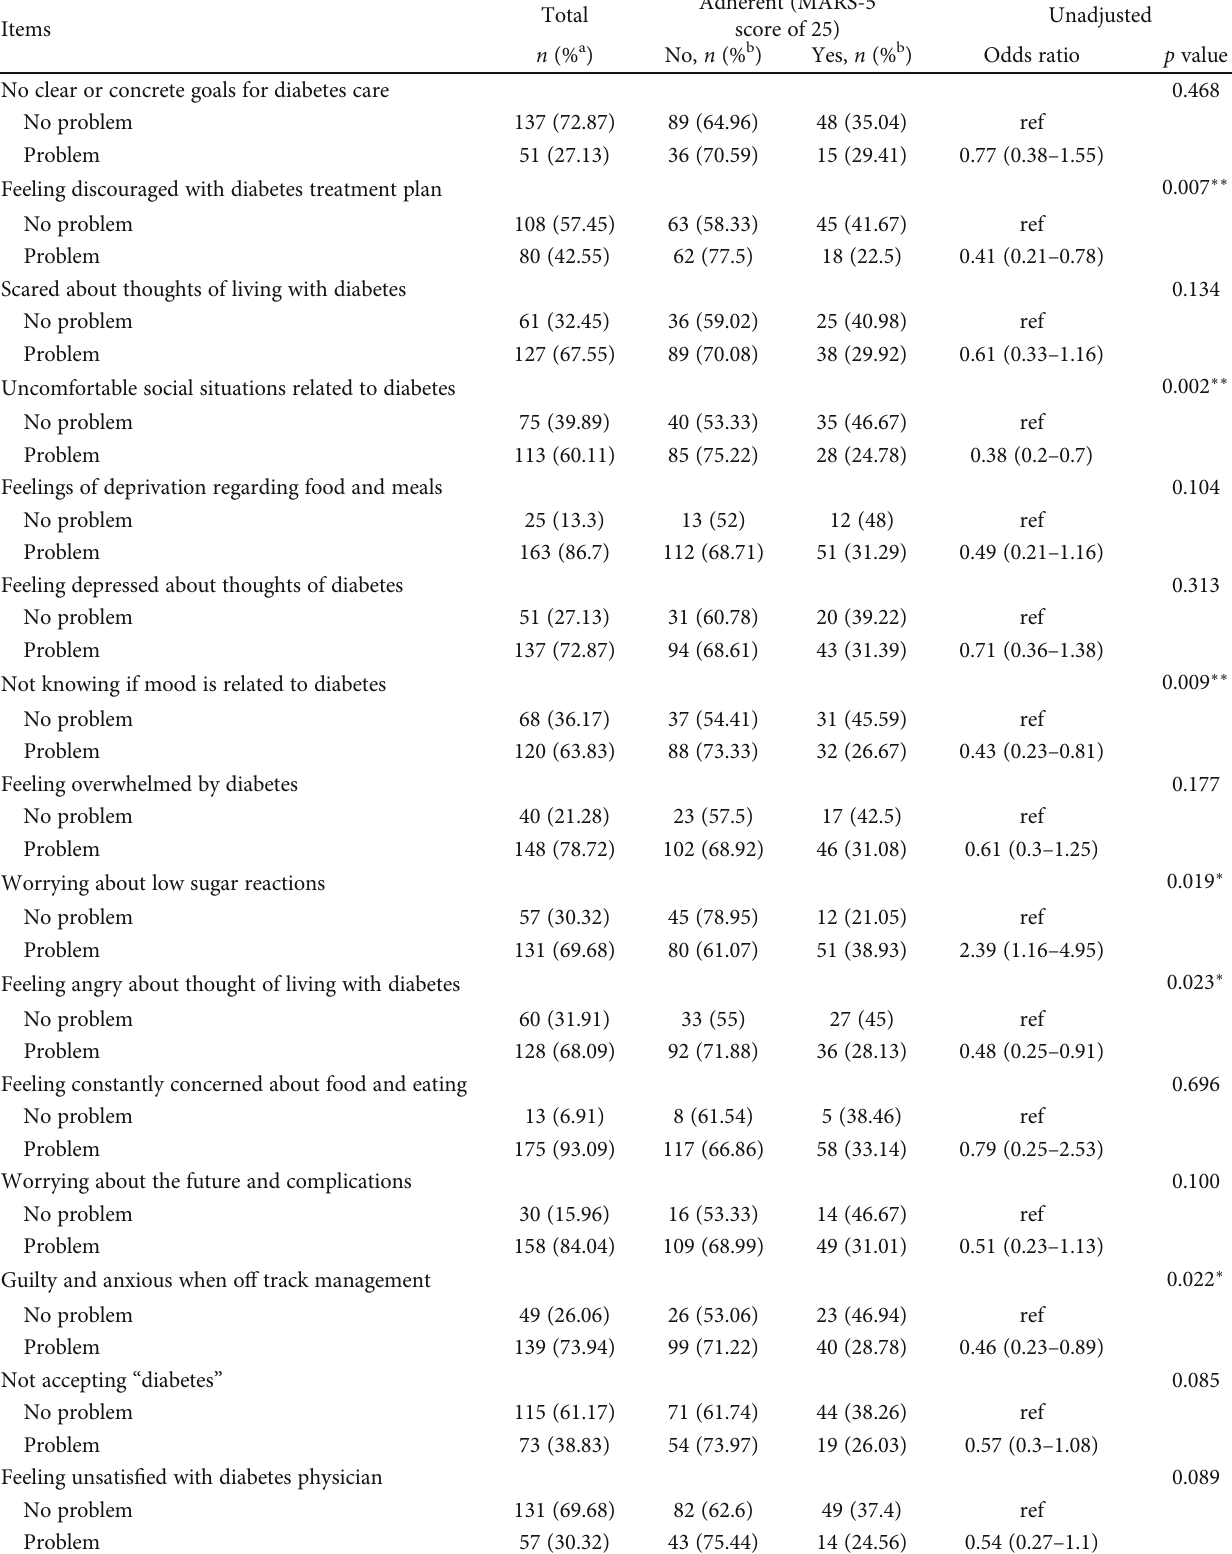
Table 4: Association between individual item responses of PAID scale and medication adherence status of patients with T2DM receiving treatment at Pantang